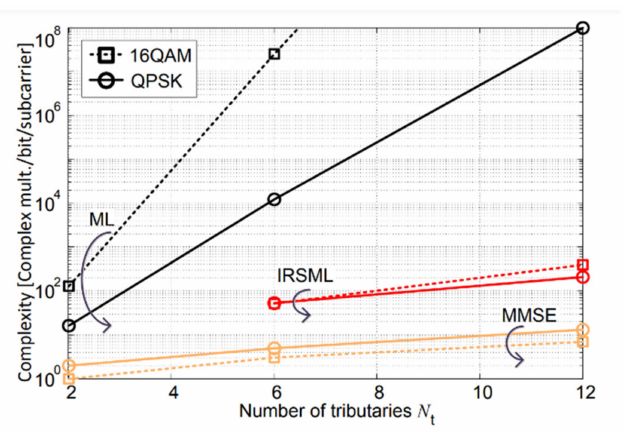
Figure 9. Number of complex multiplications per bit as a function of the number of tributaries NT for the MMSE equalizer, IRSML and ML detector for different modulation